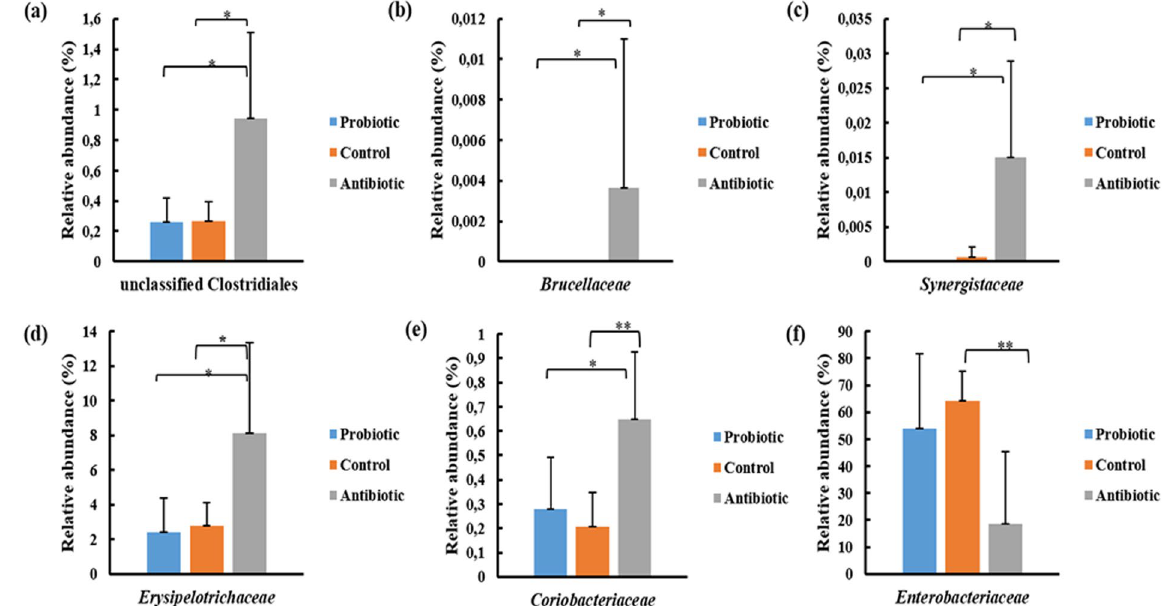
Figure 8. Cecal bacterial families, i.e. ( a ) unclassified Clostridiales, ( b ) Brucellaceae , ( c ) Synergistaceae , ( d ) Erysipelotrichaceae , ( e ) Coriobacteriaceae and ( f ) Enterobacteriaceae whose abundance significantly differs between the different treatments groups’ i.e. multi-strain probiotic, antibiotic combination and untreated (ANOVA significance, * indicates p < 0.05 and ** p <